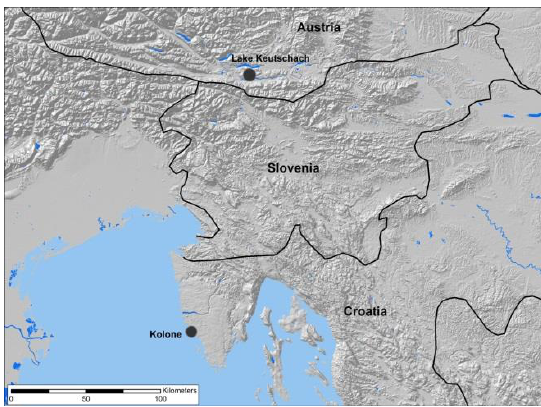
Figure 2. Geographical location of the two case study